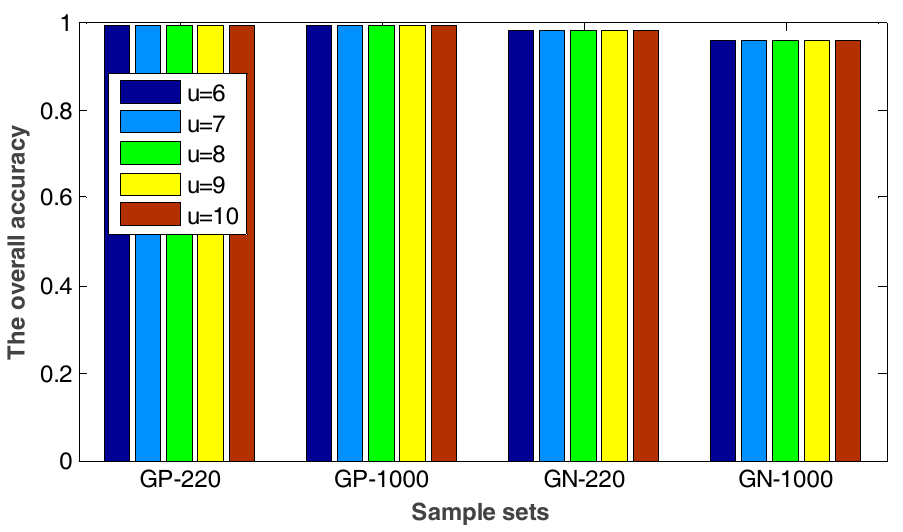
Figure 4. The overall accuracy for four sample sets with different u values.